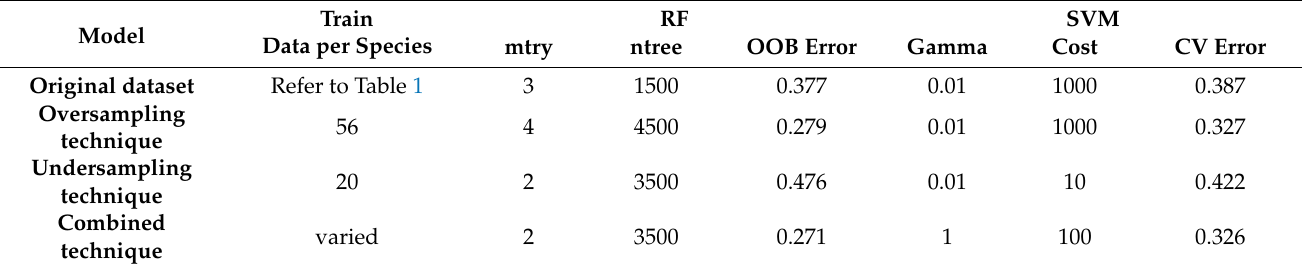
Table 3. The RF and SVM model optimization